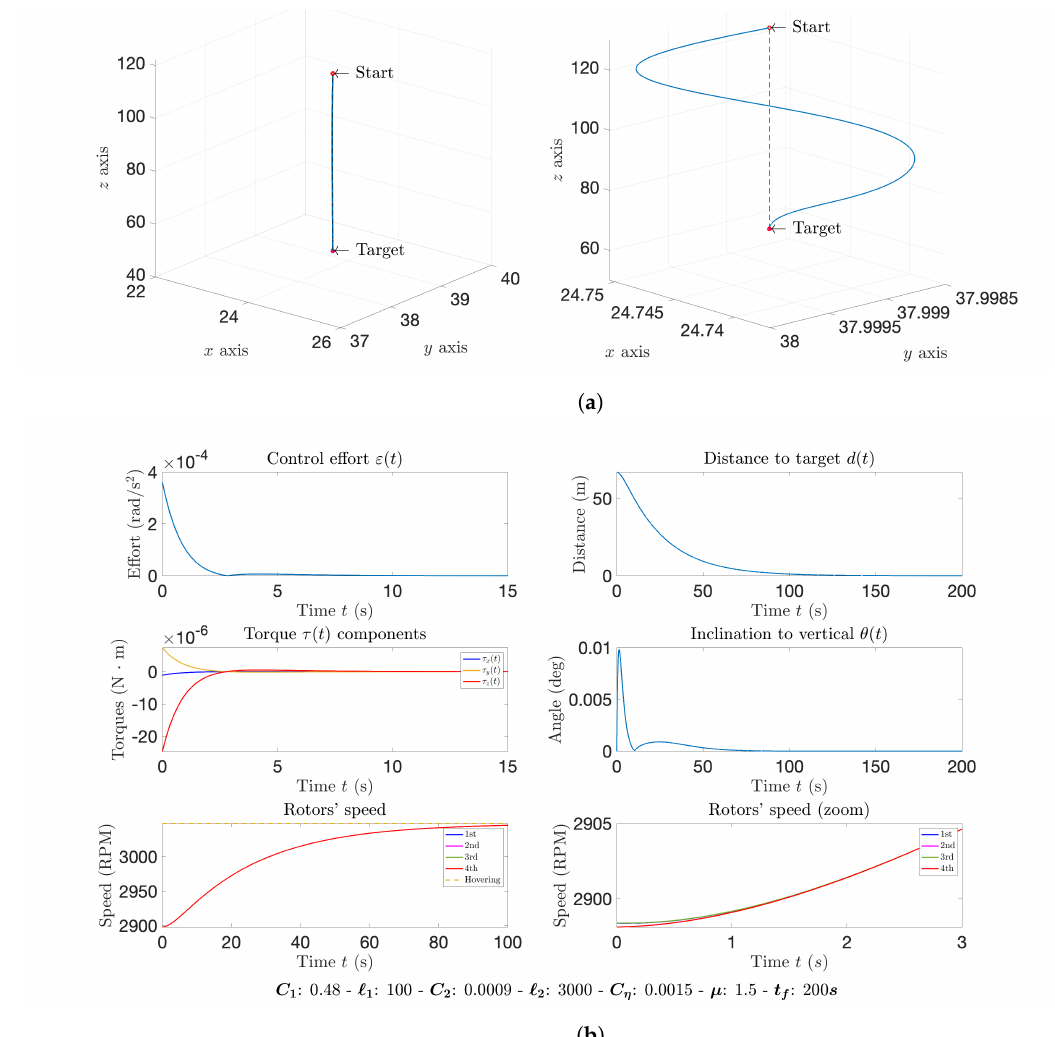
Figure 8. Experiment: Vertical ascension, favorable initial conditions. ( a ) Target approaching trajec- tory.; ( b ) Control